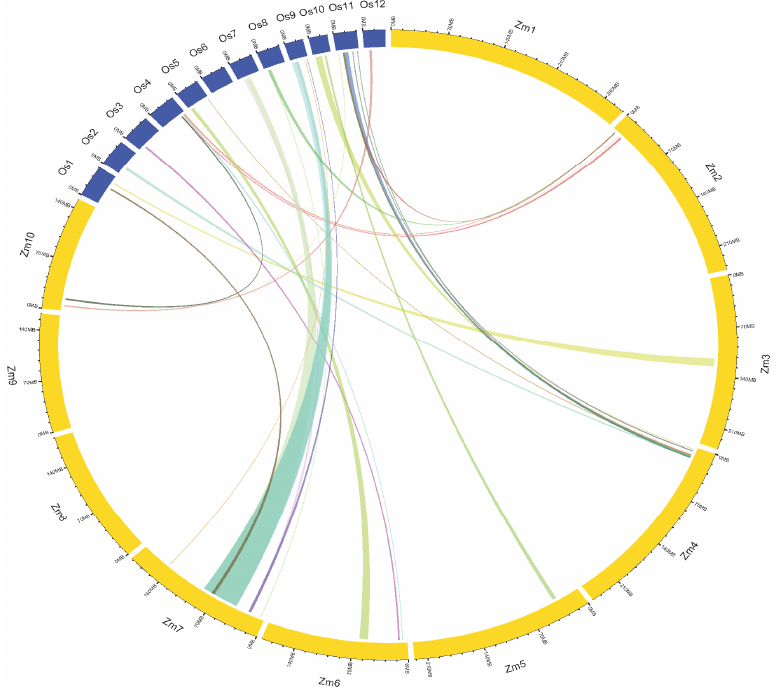
Figure 6. Conserved regions among ortho-MQTLs in maize ( Zm ) and rice genomes (Os). The outer circles represent the maize (yellow) and rice (blue) chromosomes. The linking lines represent the syntenic regions of rice and maize.